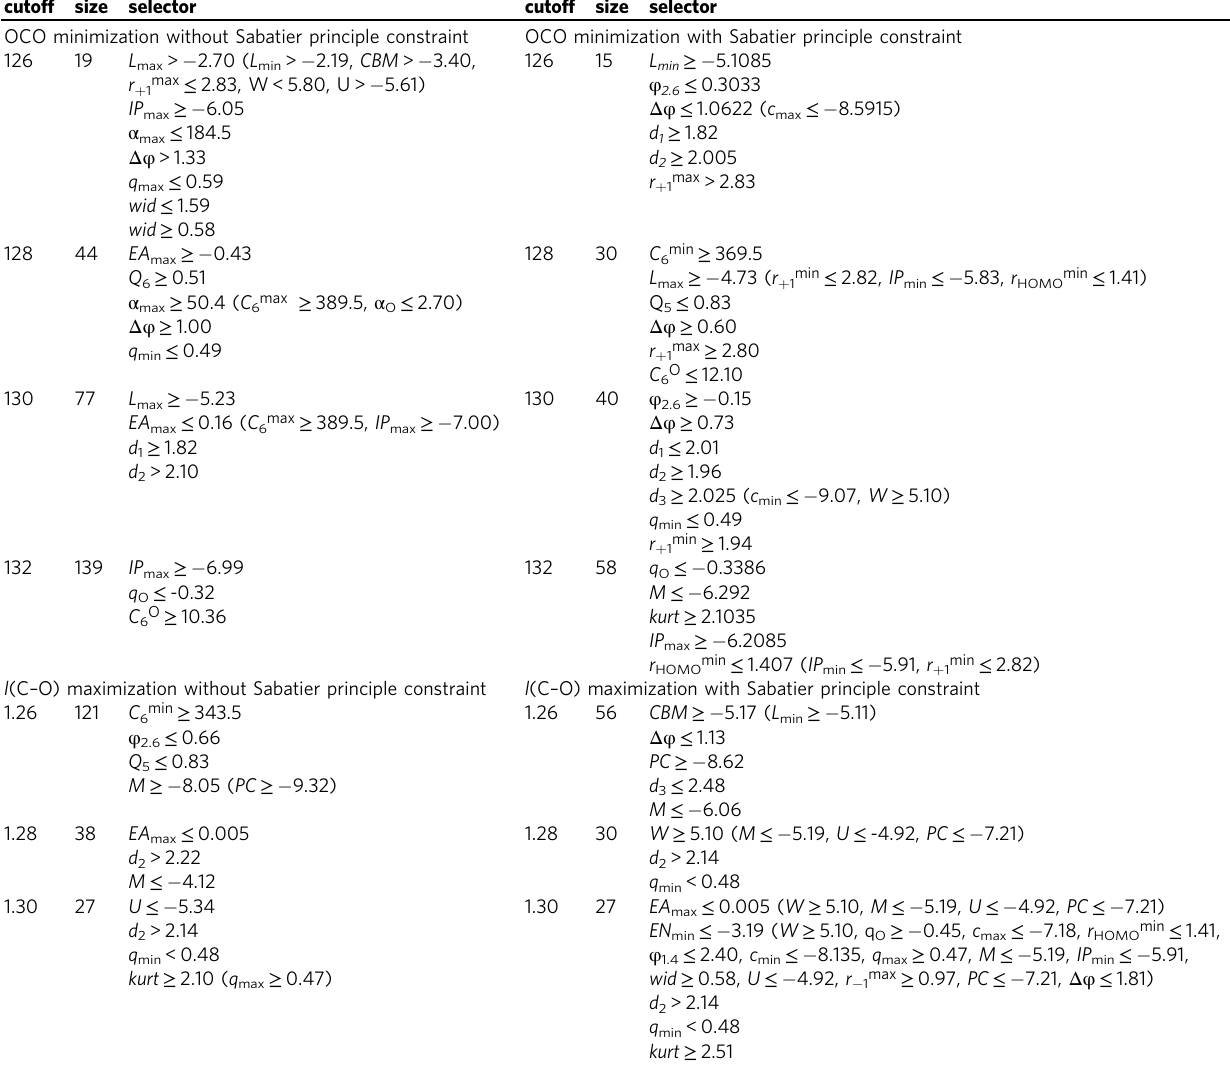
Table 2 Top subgroups and their selectors obtained by minimization of OCO-angle and maximization of l (C – O) with/out Sabatier principle (energies are in eV, distances are in Å, charges are in units of absolute electron charge, polarizabilities are in Bohr 3